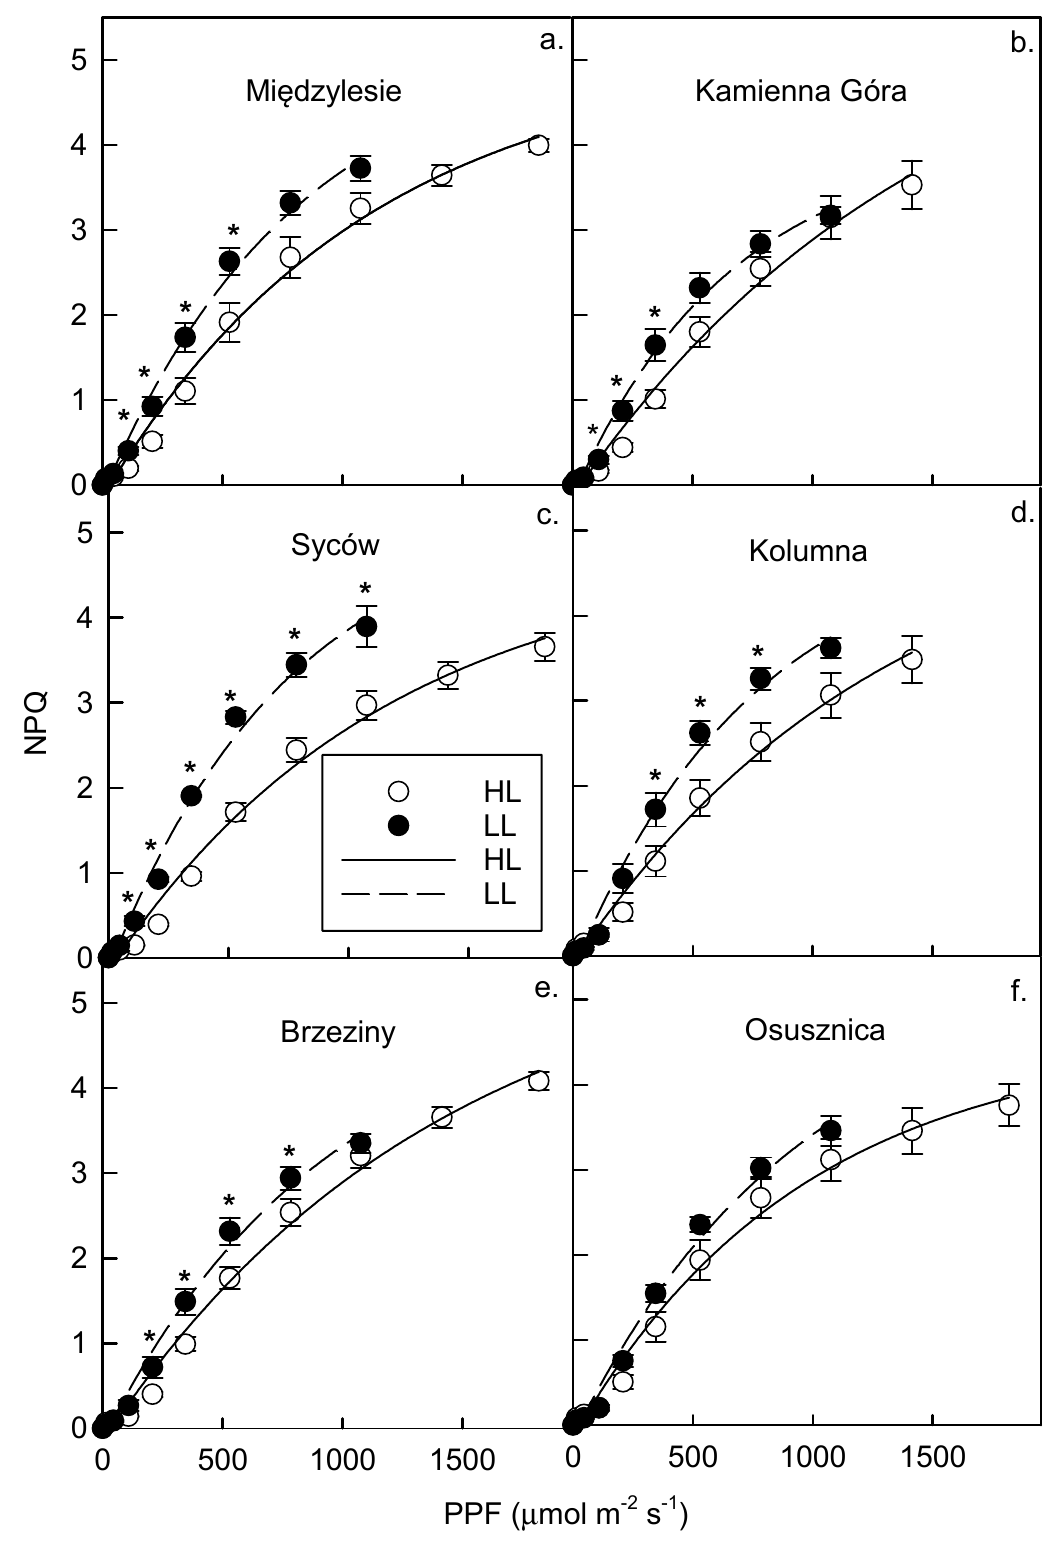
Figure 6. Light curves of non-photochemical quenching of fluorescence ( NPQ ) in needles of Abies alba seedlings originating from different provenances and acclimated to full irradiance or shade. Mean values (±SE) of NPQ are shown for each provenance in plots ( a – f ) in shade and in full irradiance. An asterisk indicates that the mean values of NPQ at the given actinic PPF value are significantly different using Student’s t- test at p < 0.05 ( n = 5). PPF —photosynthetic photon flux.